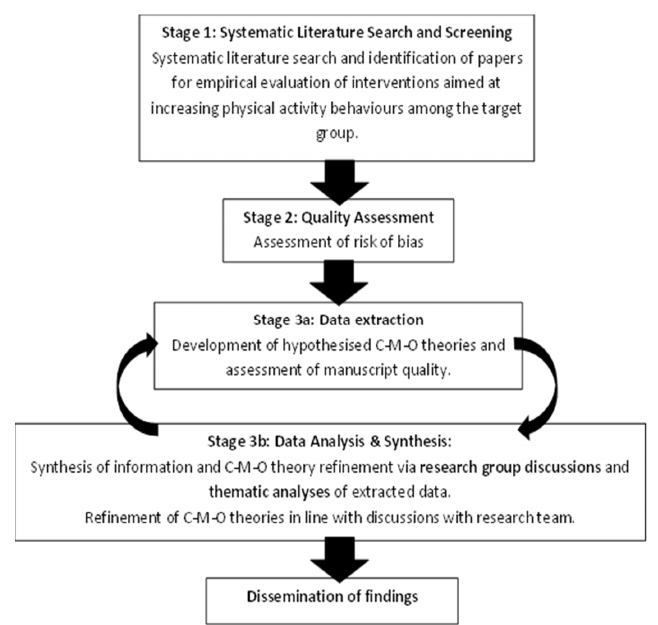
Figure 1. Schematic of proposed methodology.